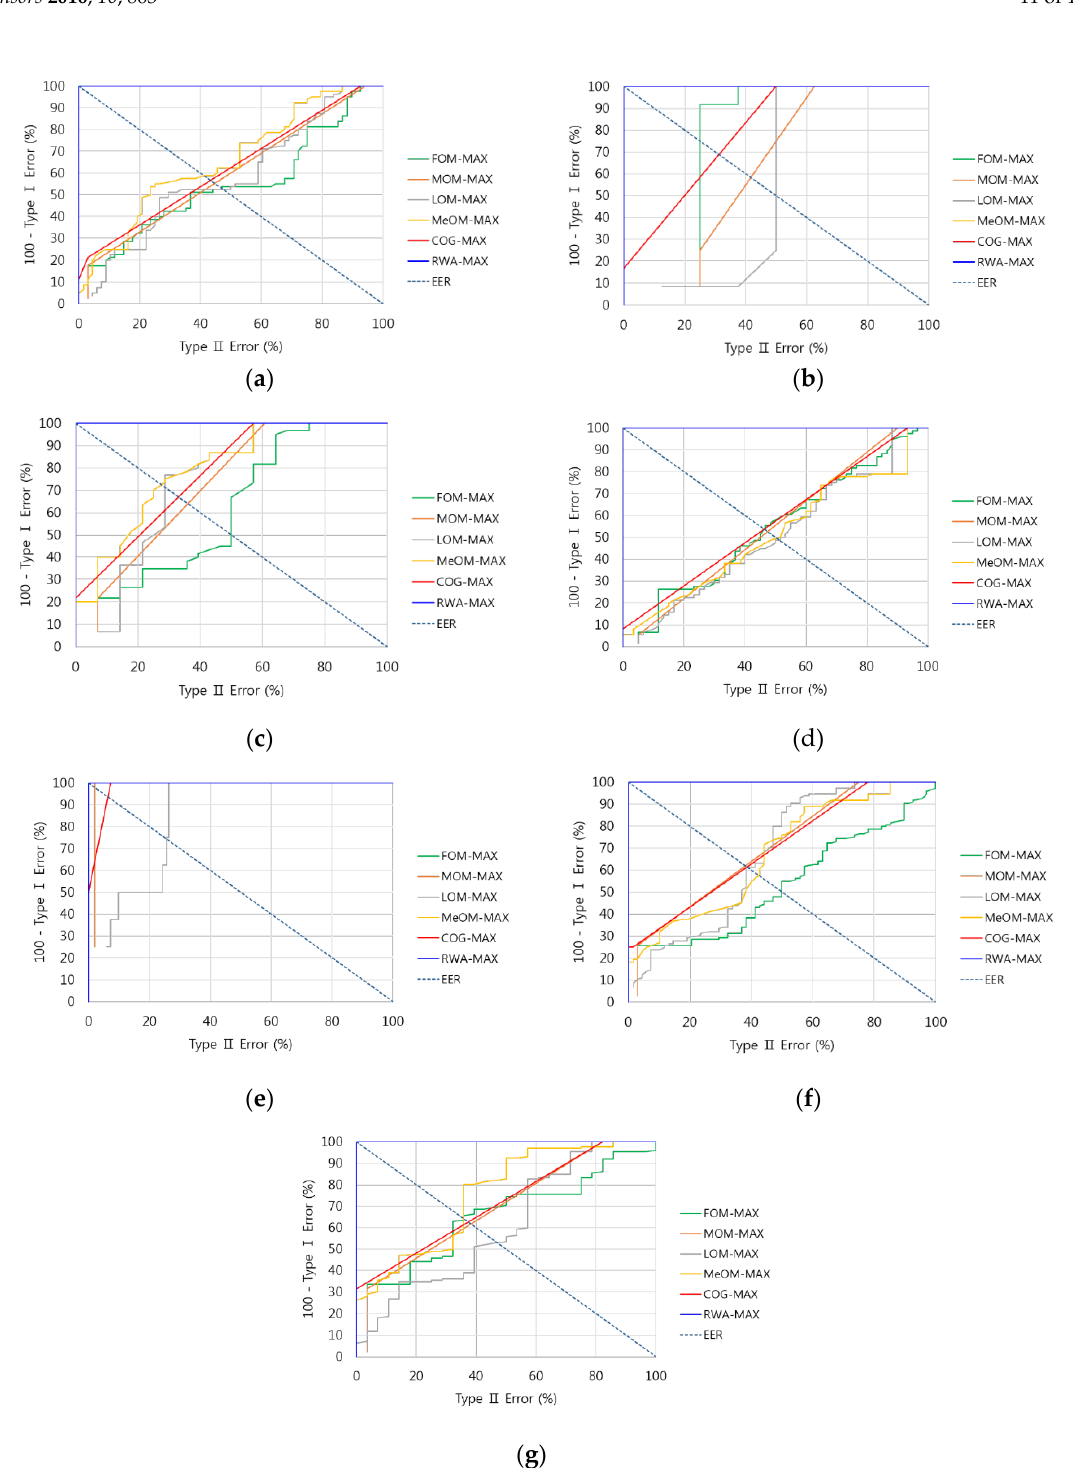
Figure 8. Examples of ROC curves for the error in each defuzzification method when using the Max rule: ( a ) $1 direction A; ( b ) $2 direction A; ( c ) $5 direction A; ( d ) $10 direction A; ( e ) $20 direction A; ( f ) $50 direction A; ( g ) $100 direction A.